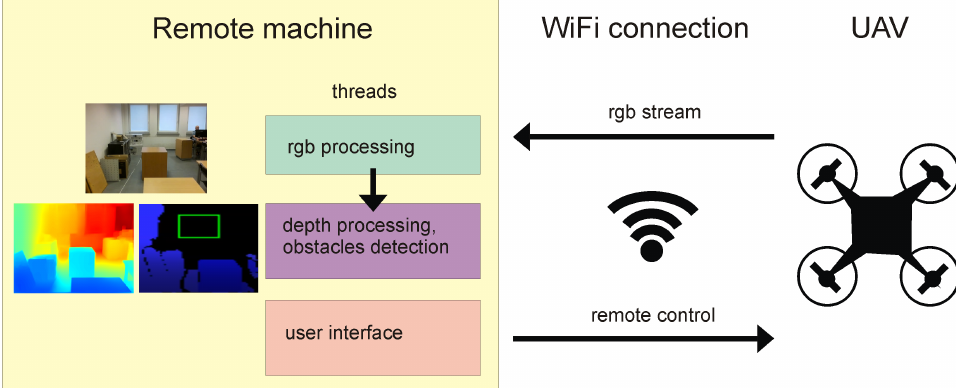
Figure 3. Diagram of the architecture of the system combining Algorithm 1 with